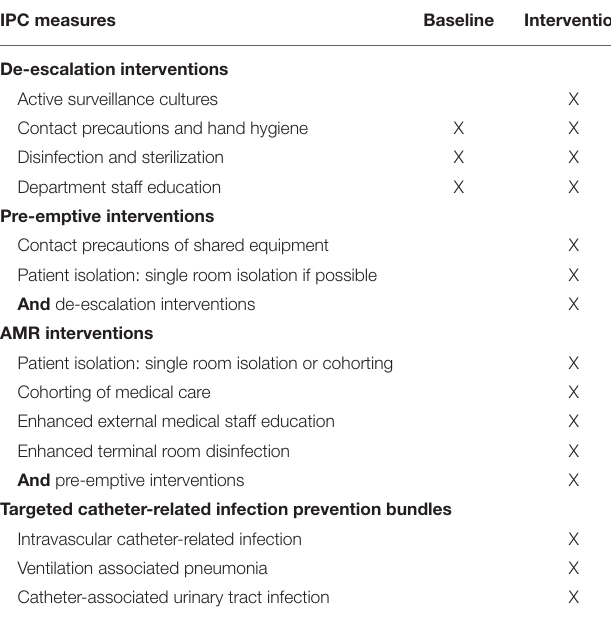
TABLE 1 | Implementation of infection prevention and control (IPC) measures during the baseline and intervention